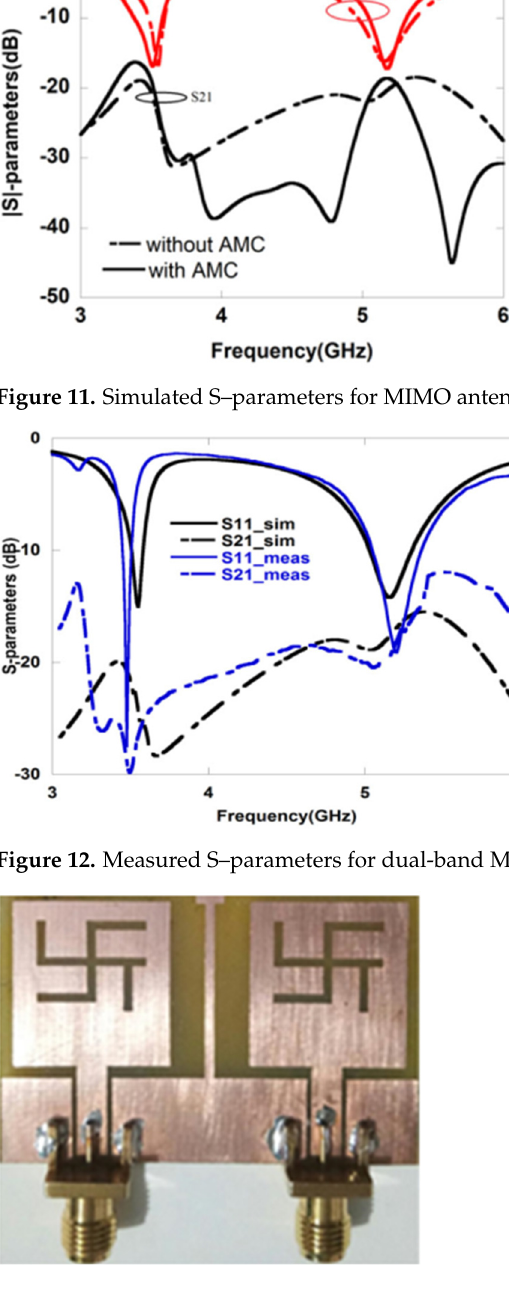
Figure 13. Fabricated two-element dual-band MIMO antenna [48].